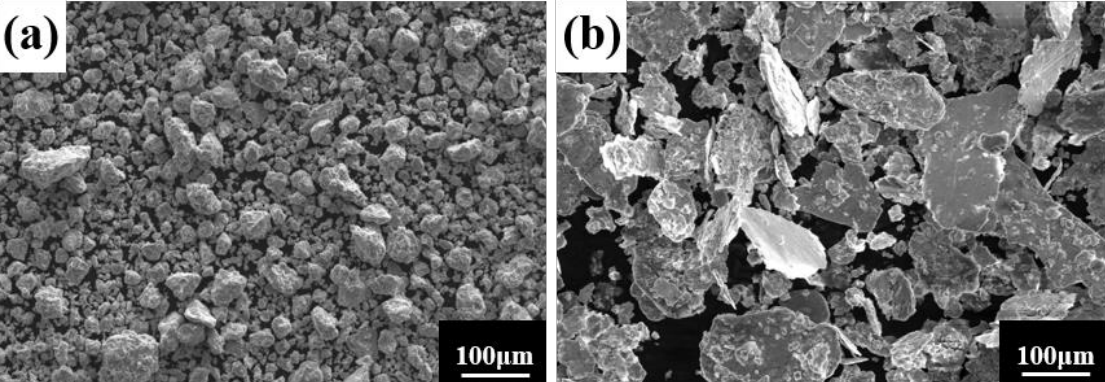
Figure 7. Powder microstructures with different PCA at a milling speed of 500 r min −1 for 30 h: ( a ) ethanol; and ( b ) stearic acid.